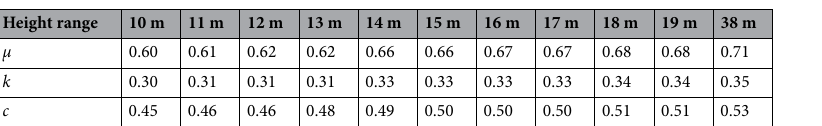
Table 4. Values of μ , k , and c at each observation